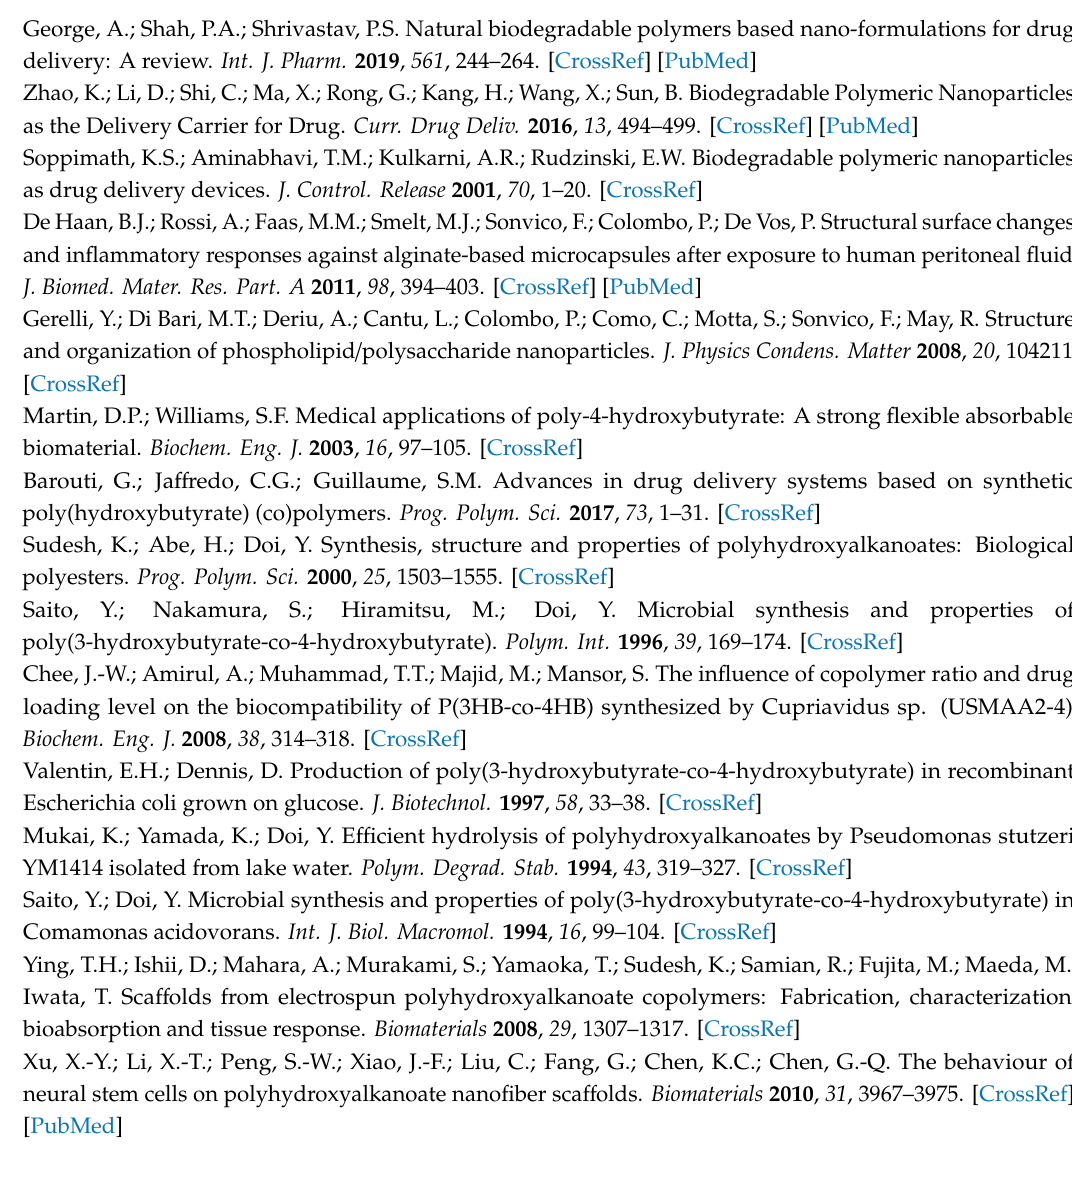
Figure S1: Particle size (bars) and PDI values (lines) of P(3HB-co-4HB) nanoparticles stored at di ff erent